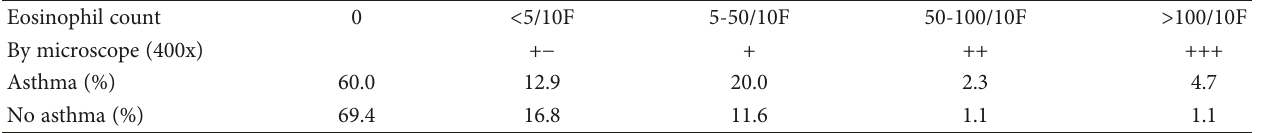
Table 2: Nasal eosinophil counts for each group.